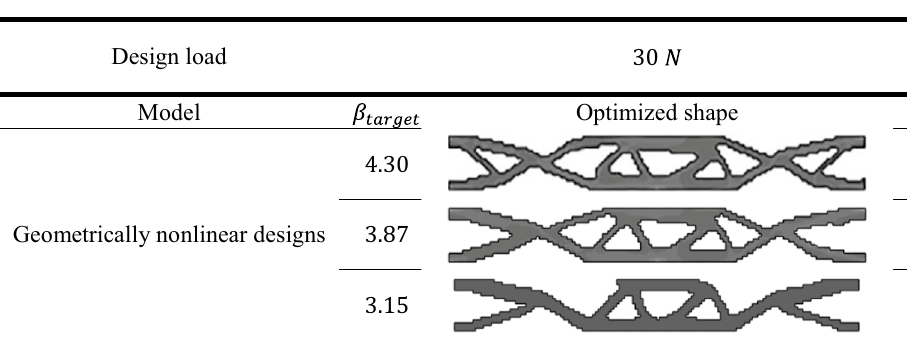
Table 4. The optimal solution of probabilistic geometrically nonlinear design of the model.